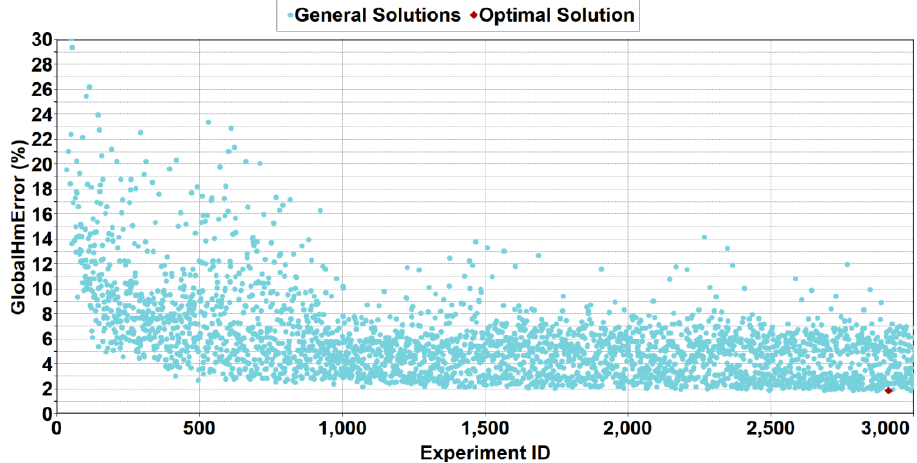
Figure 6—Global error of historical matching vs the trial